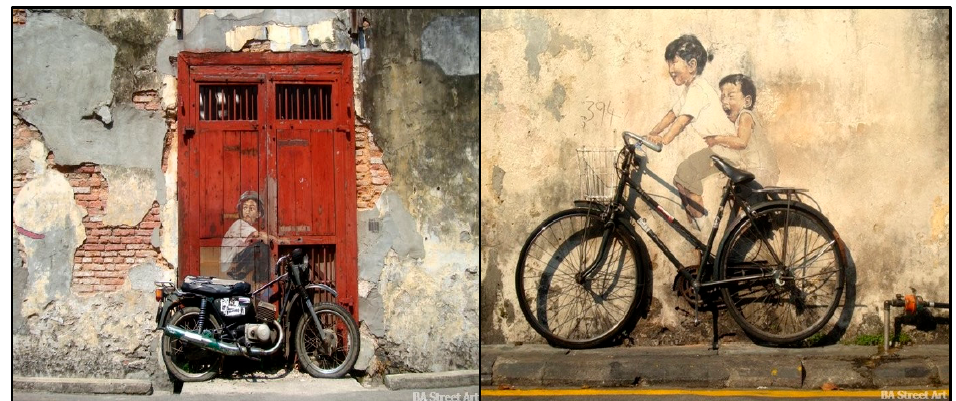
Figure 1. Murals in George Town. Source: [20].